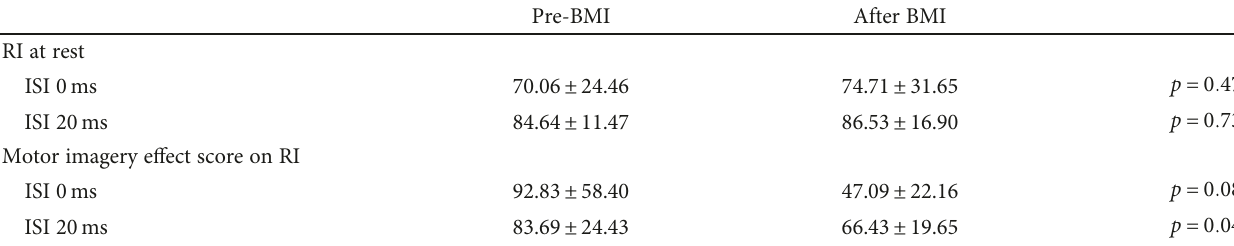
Table 4: Motor imagery e ff ect on reciprocal inhibition after brain-machine interface